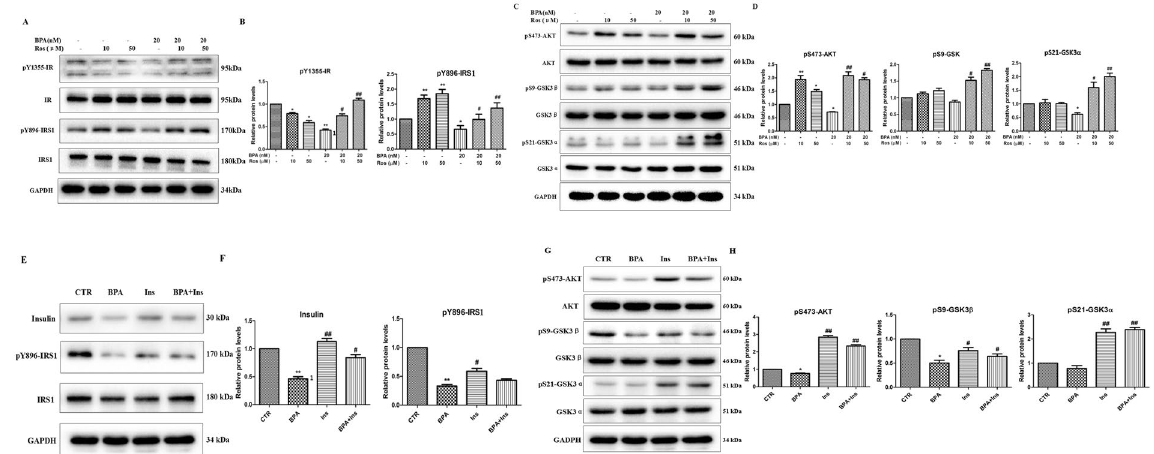
Figure 5. Effects of rosiglitazone and insulin on BPA-induced insulin signaling pathways. ( A ) Effects of rosiglitazone on the expression of IR and IRS tyrosine phosphorylation mediated by BPA in SY5Y cells. ( C ) Effects of rosiglitazone on the expression of AKT and GSK3 α /3 β serine phosphorylation mediated by BPA in SY5Y cells. ( E ) Effects of insulin on the expression of phosphorylated IR and phosphorylated IRS mediated by BPA in SY5Y cells. ( G ) Effects of insulin on the expression of phosphorylated AKT and GSK3 α /3 β mediated by BPA in SY5Y cells. ( B , D , F , H ) GAPDH levels were assessed in parallel and served as controls. Mean values ± SEMs are representative of three independent isolations and three independent samples. Significant differences between the treatment groups and the control group were determined via one-way ANOVA and the Dunnett multiple comparison procedure. ( * P < 0.05, ** P < 0.01 compared with the BPA single treatment group, # P < 0.05, ## P <